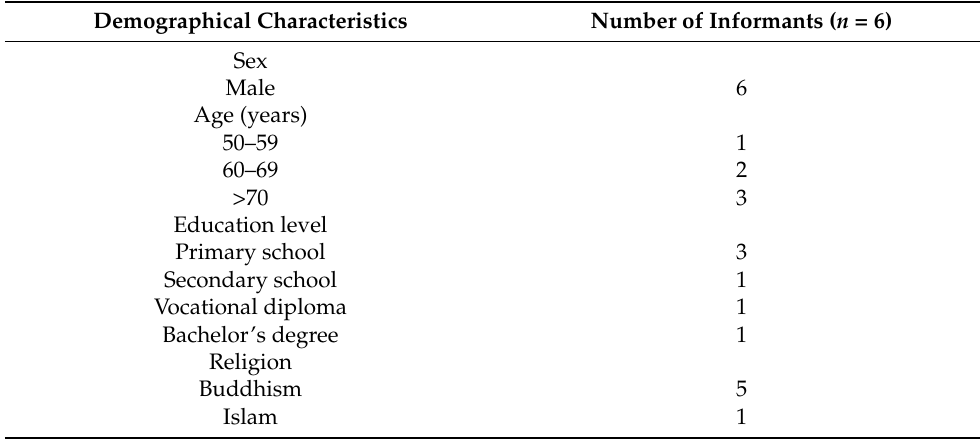
Table 1. Demographical characteristics of experienced traditional healers in the Songkhla province, Thailand. Demographical Characteristics